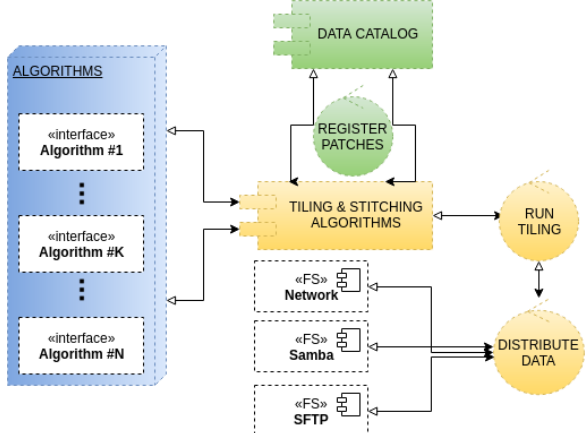
Fig.4 Architecture of Tiling and Stitching